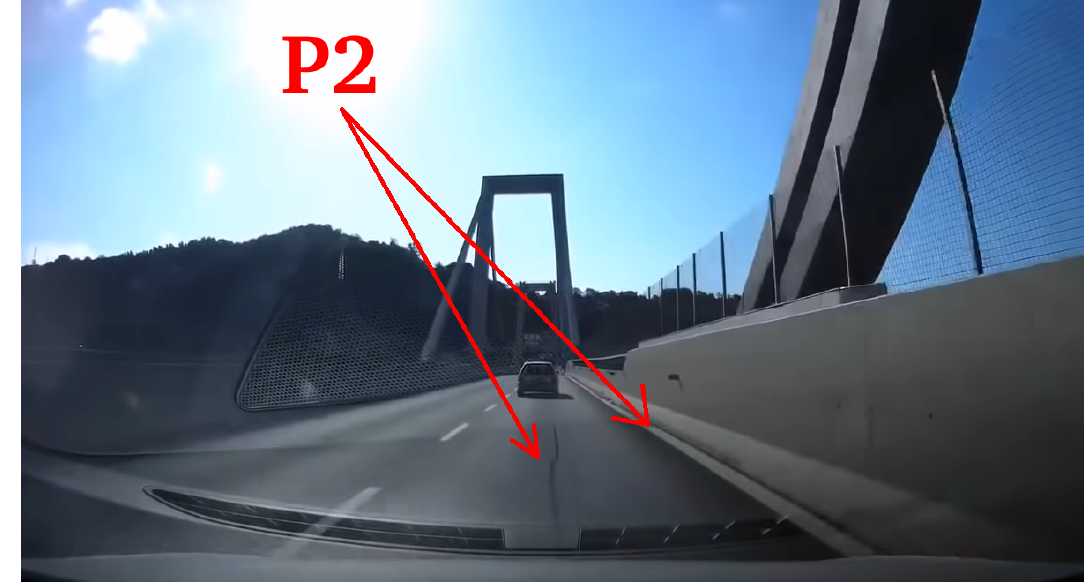
Figure 35. Optical representation of “Morandi” bridge (longitudinal